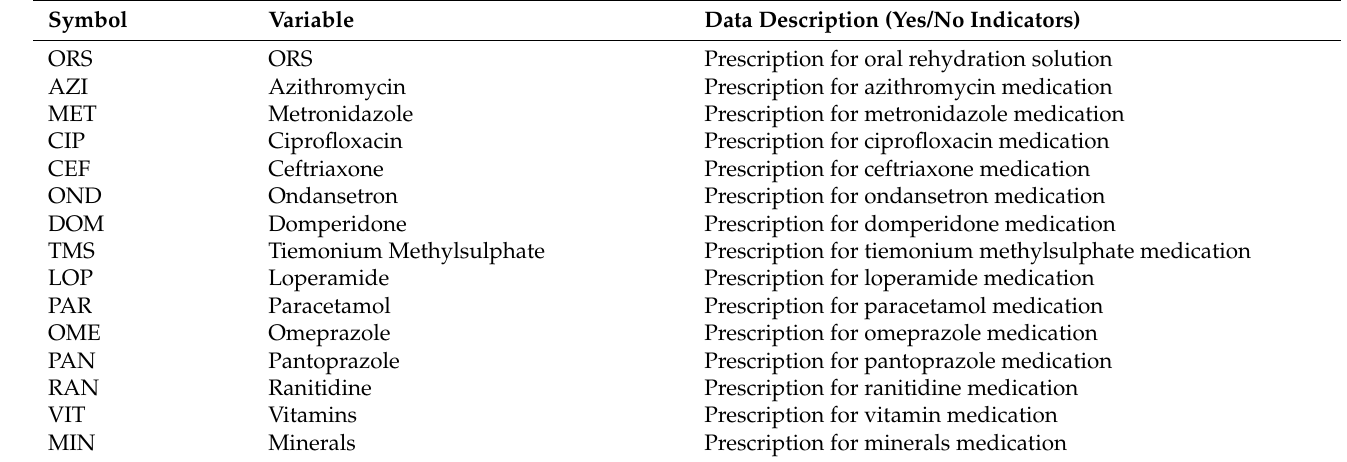
Table 2. Data variables on doctor’s medication prescription.